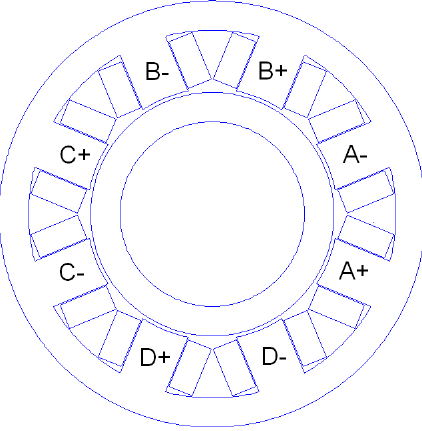
Figure 4. Eight-pole magnetic bearing with a horseshoe